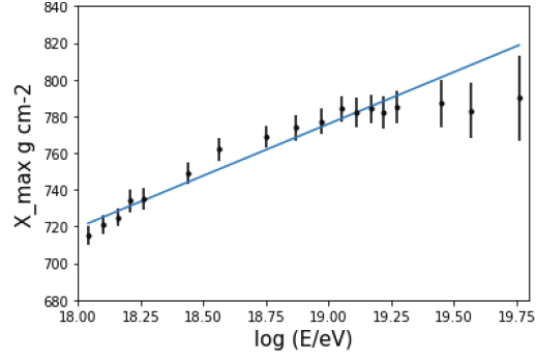
Fig.3b. Data of X max vs log E/eV from Yakutsk. The Elongation Rate above 3 EeV is 28 ± 7 g cm -2 /decade. See [2] for details.